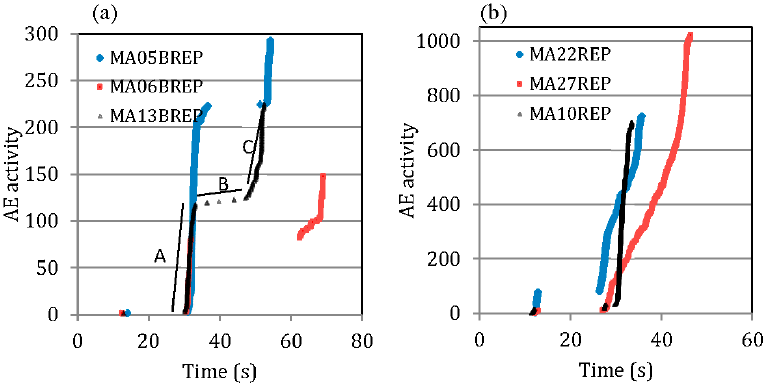
Figure 10. ( a ) Cumulative AE history for repaired MA specimens following three stages. ( b ) Cumulative AE history for repaired MA specimens without similar three stages.